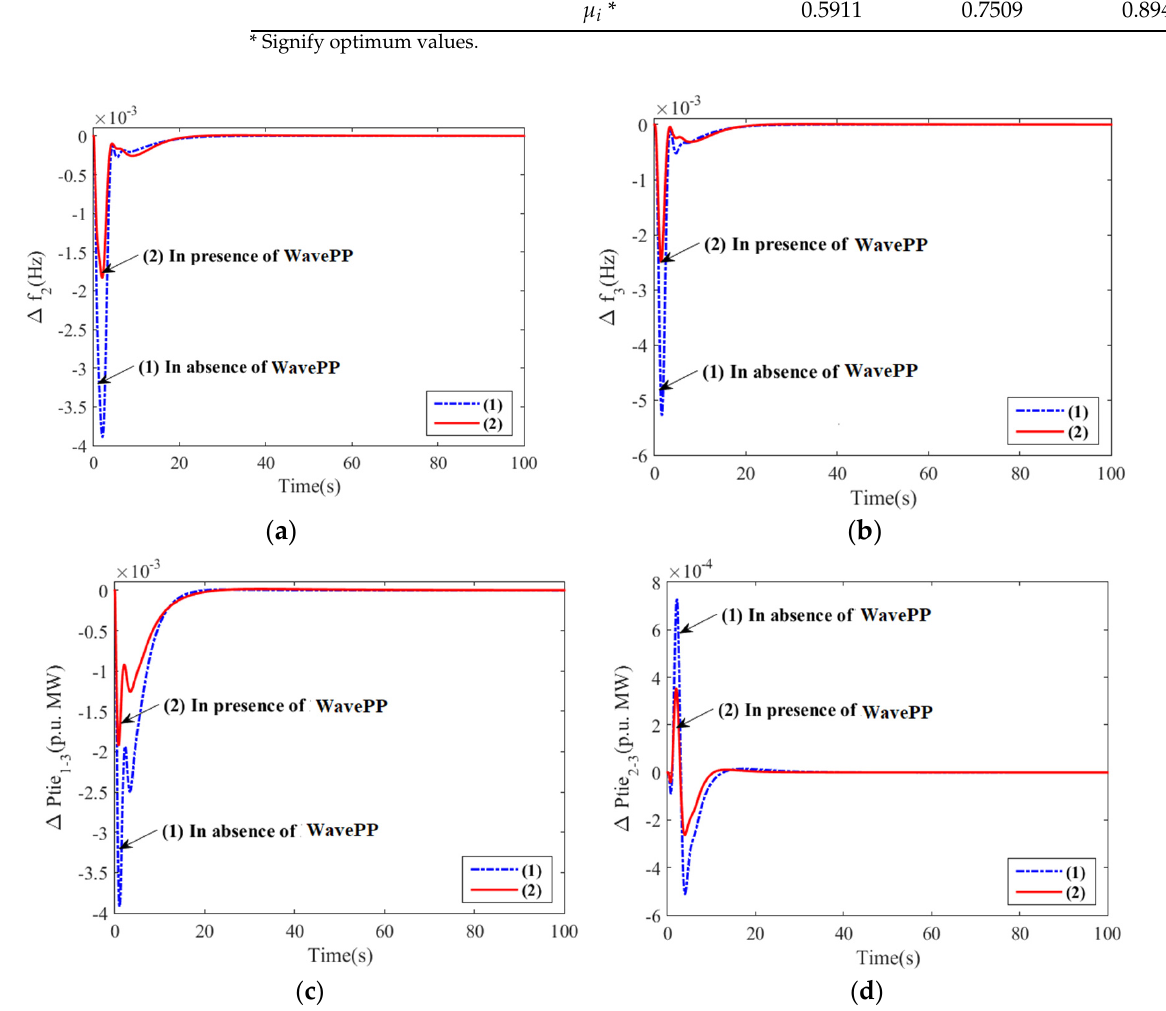
Figure 8. Evaluation of the influence of WavePPt on system changing aspects employing SHO- optimized PDN(FOID) controller in view of 1% step load disturbances for system-2 contrast time: ( a ) Anomaly of frequency in area-1, ( b ) Anomaly of frequency in area-3, ( c ) Anomaly of Tie-line power interlinking area-1 and area-3, ( d ) Anomaly of Tie-line power interlinking area-2 and area-3. Table 5. Finest values of gains and related parameters of PDN(FOID) controllers for scheme-2.